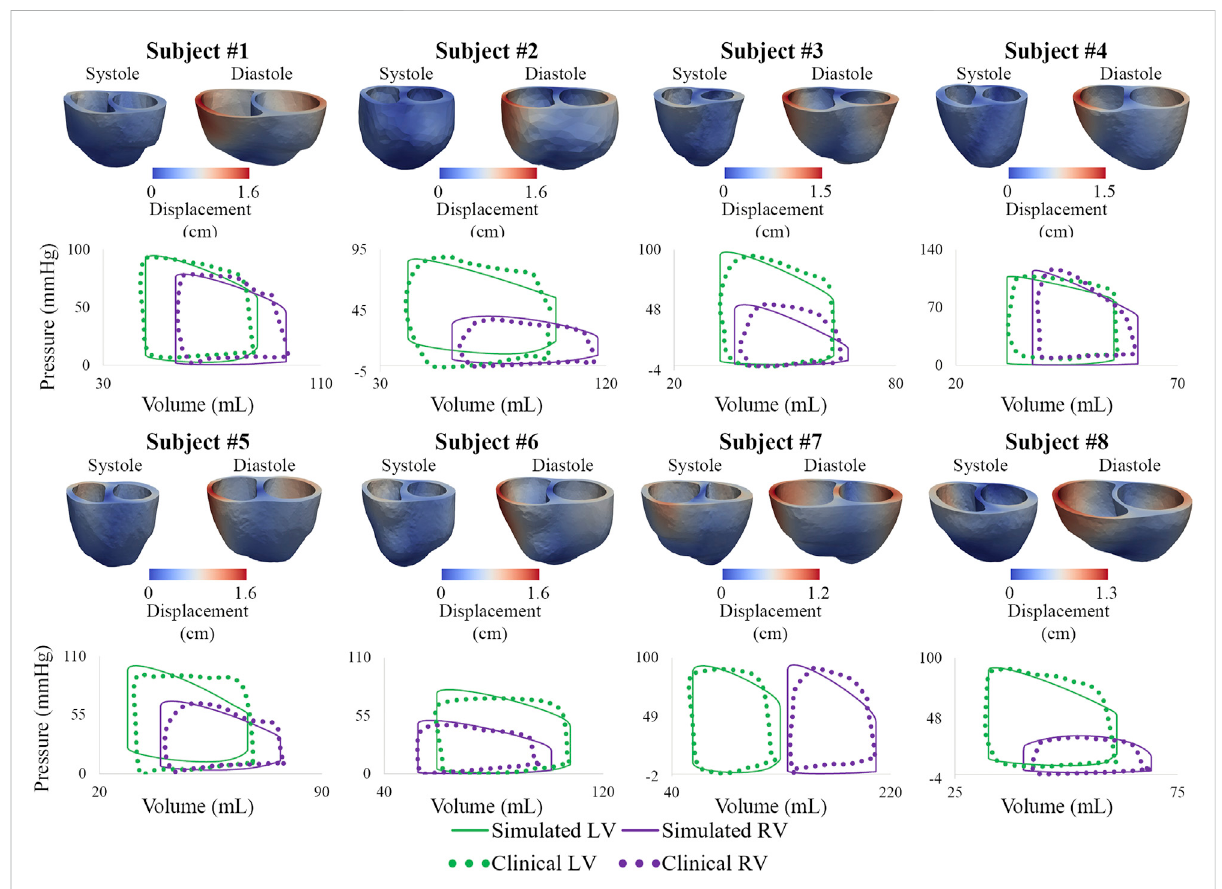
FIGURE 10 Displacement maps of ventricular models at end-systole and end-diastole. Comparison of LV and RV PV loops shows agreement between simulated and clinical